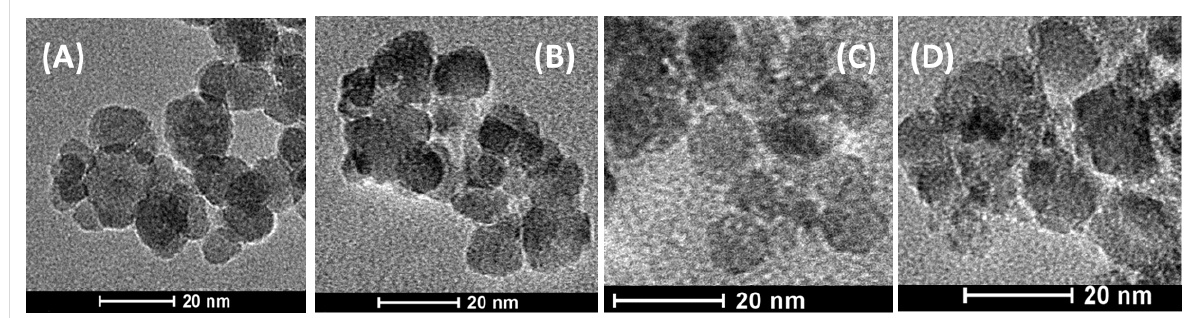
Figure 1: TEM images of the ferrite nanoparticles: A) Fe 3 O 4 , B) Co 0.5 Fe 2.5 O 4 , C) Mn 0.5 Fe 2.5 O 4 , D) Ni 0.5 Fe 2.5 O 4 .